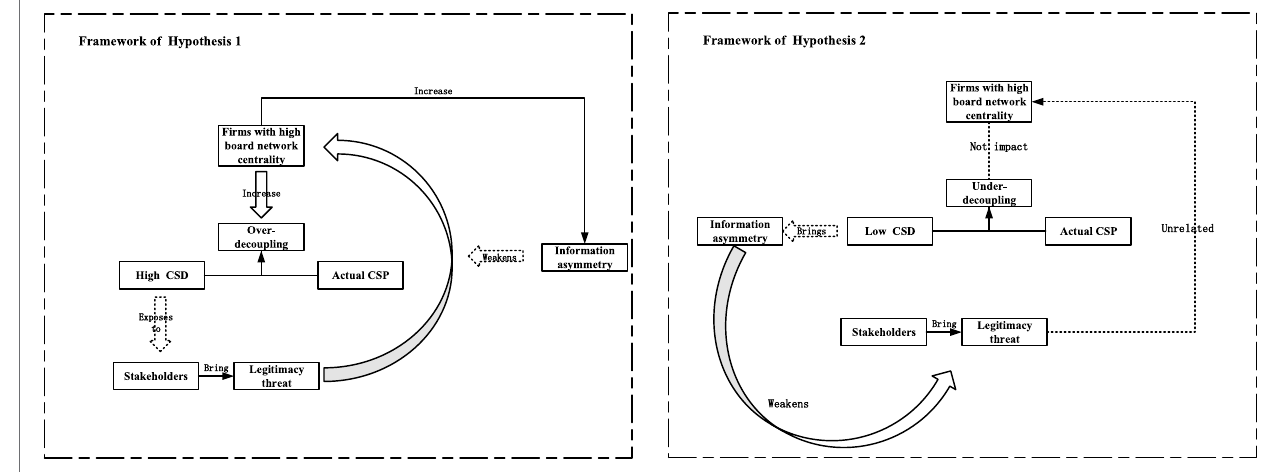
FIGURE 1 | Theoretical